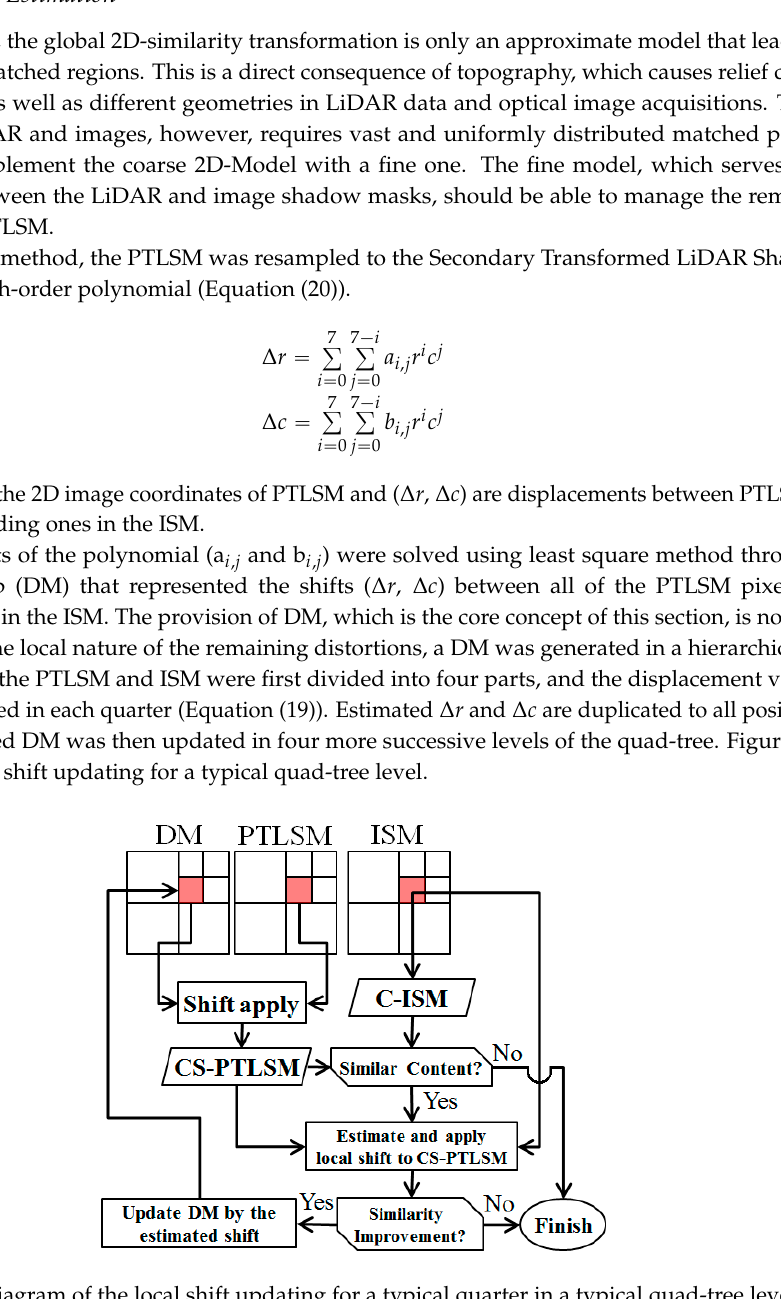
Figure 15. A diagram of the local shift updating for a typical quarter in a typical quad-tree level (here the 4th quarter of the 2nd level).